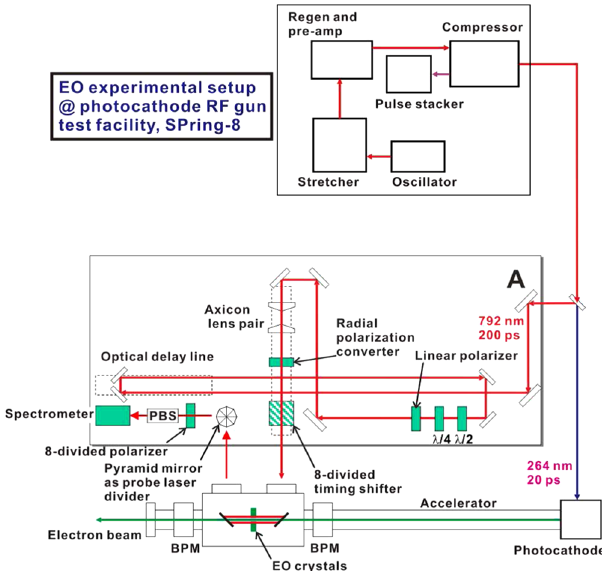
FIG. 9. Experimental apparatus for a 3D-BCD monitor feasi- bility test at the photocathode rf gun test facility,